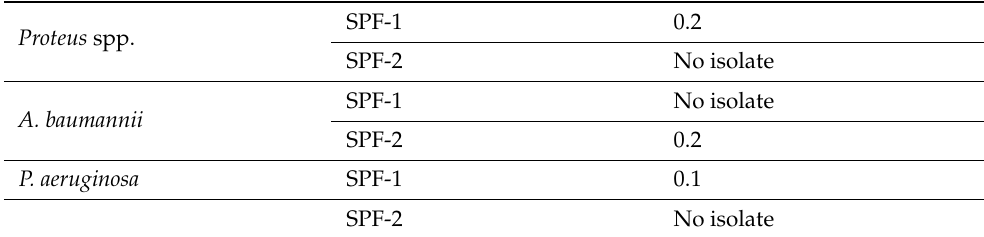
Table 4. Cont. Proteus